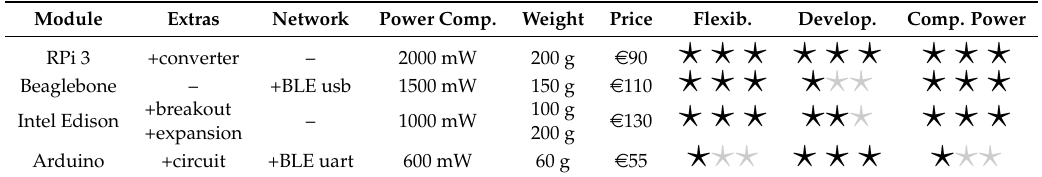
Figure 20. Proposed mobile sensing solutions for air quality monitoring. Table 7. Comparison of the four different solutions